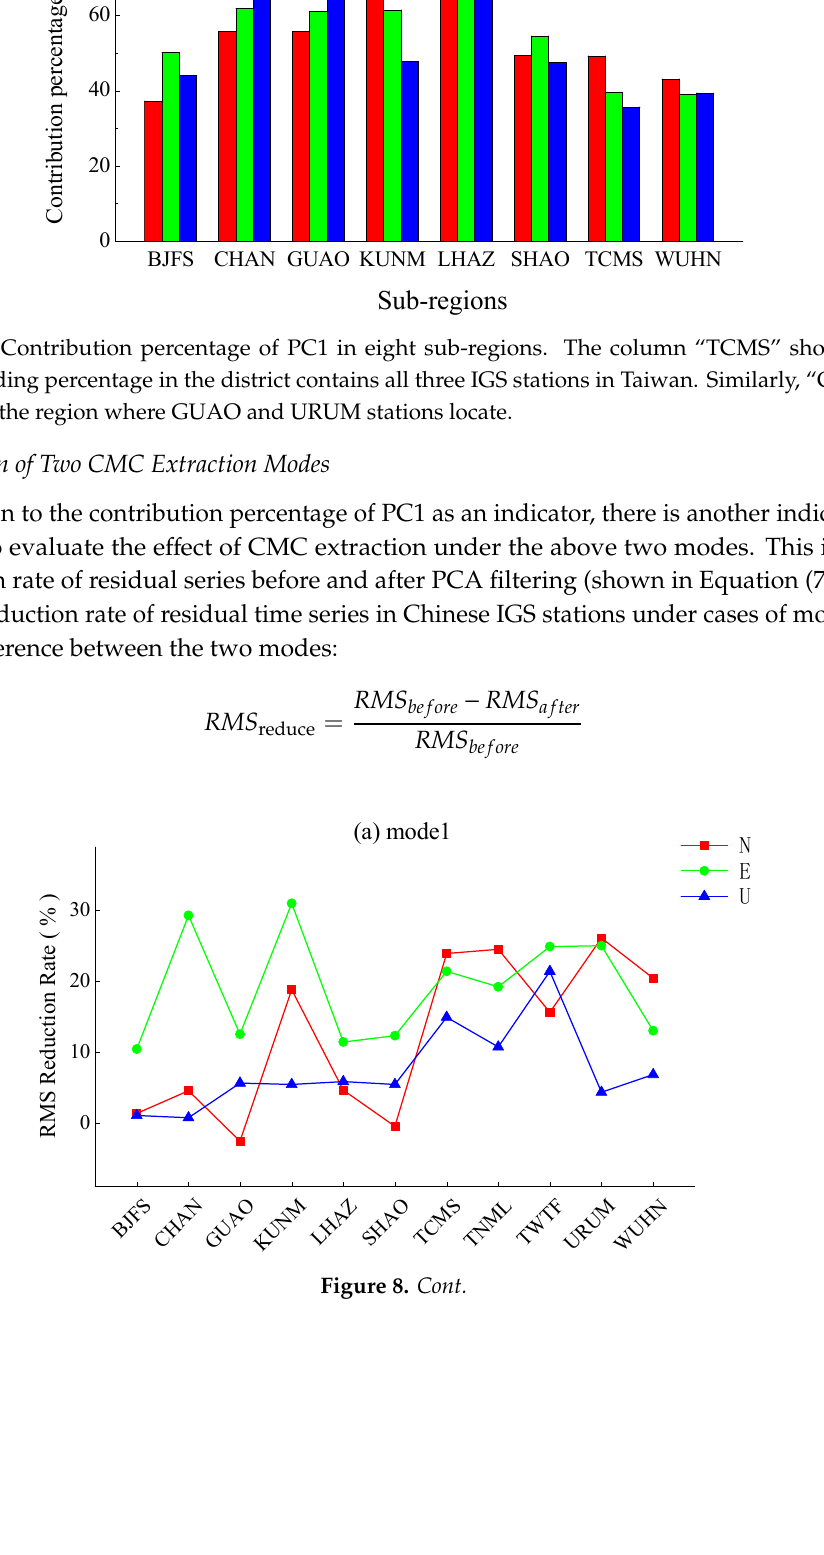
Figure 7. Contribution percentage of PC1 in eight sub-regions. The column “TCMS” shows the corresponding percentage in the district contains all three IGS stations in Taiwan. Similarly, “GUAO” stands for the region where GUAO and URUM stations locate.